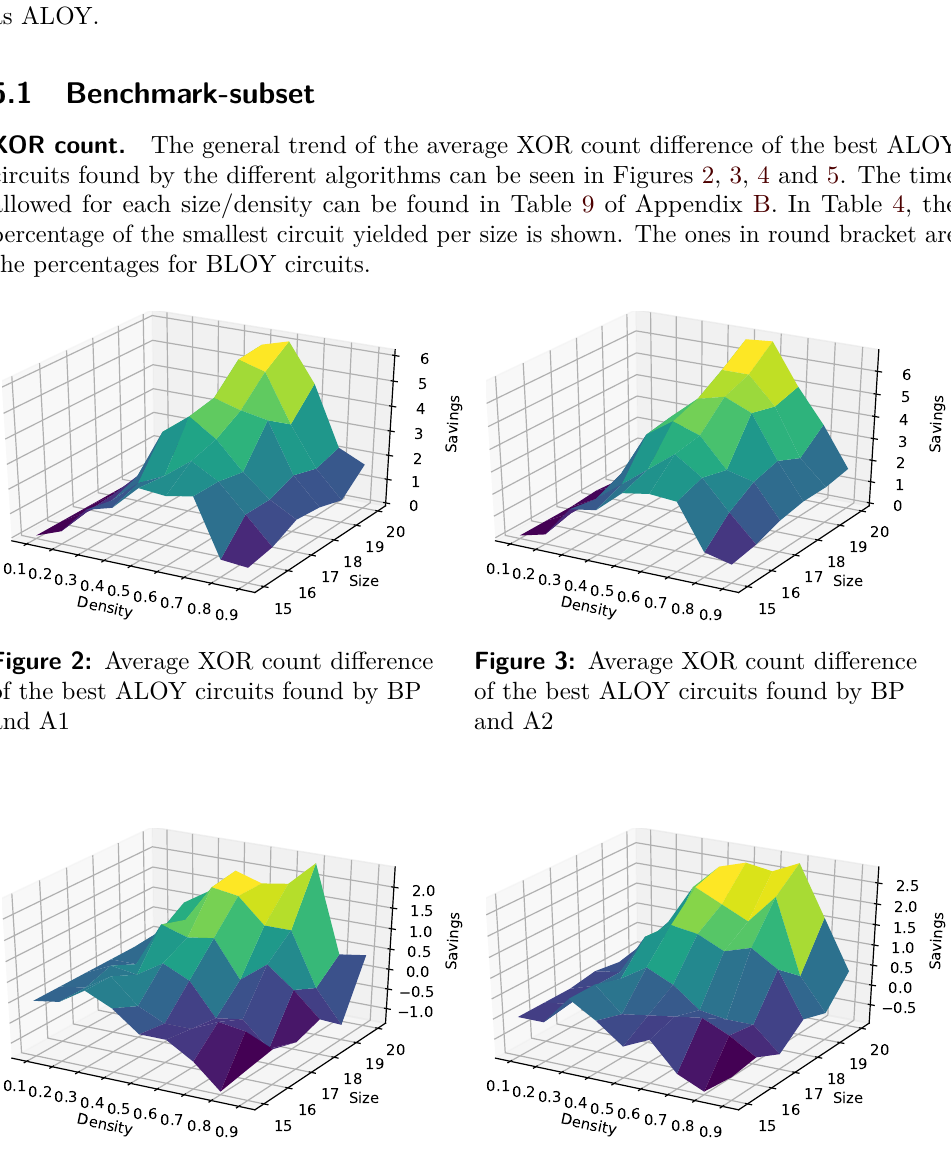
Figure 5: Average XOR count difference of the best ALOY circuits found by RSDF and